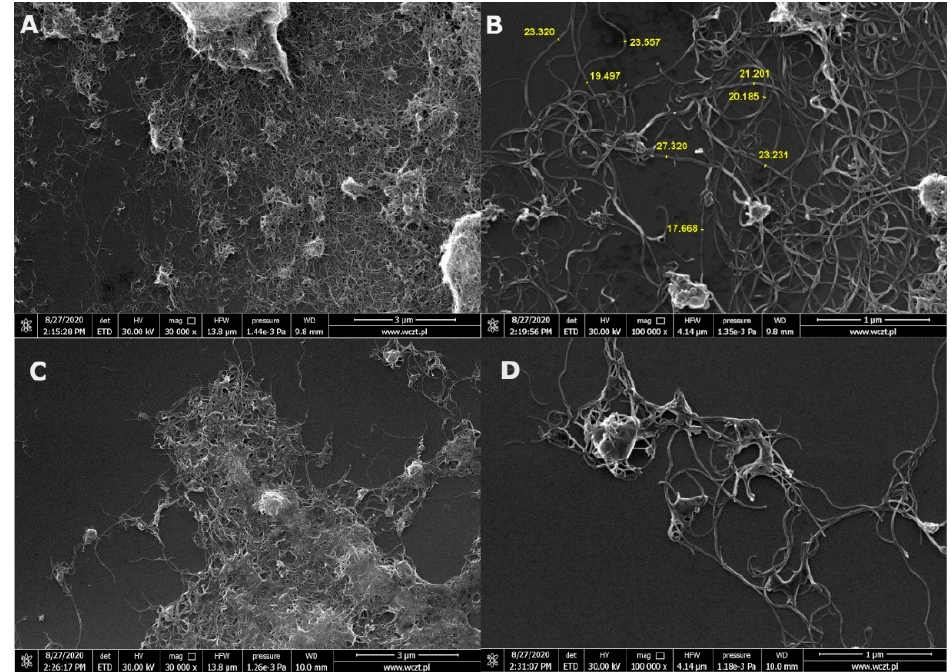
Figure 1. Scanning electron microscopy (SEM) images of both multiwalled carbon nanotubes (MWCNTs) ( A , B ) and functionalized oxidized, multiwalled carbon nanotubes (MWCNT-Ox) ( C , D